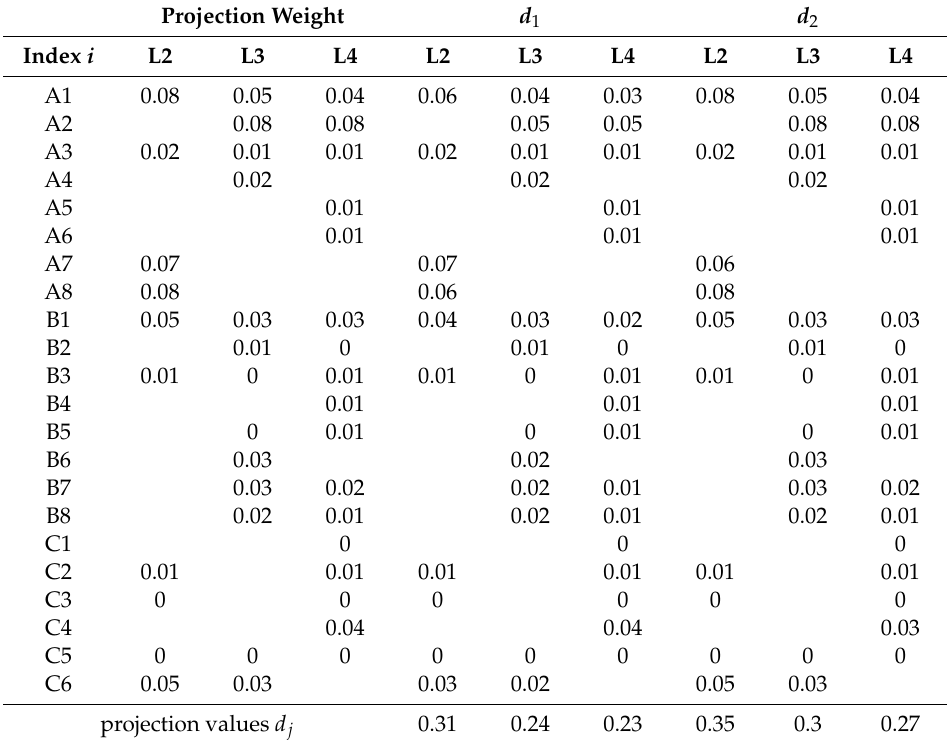
Table 7. Evaluation results of project benefit based on international lending institutions, sending- oriented states, and receiving-oriented